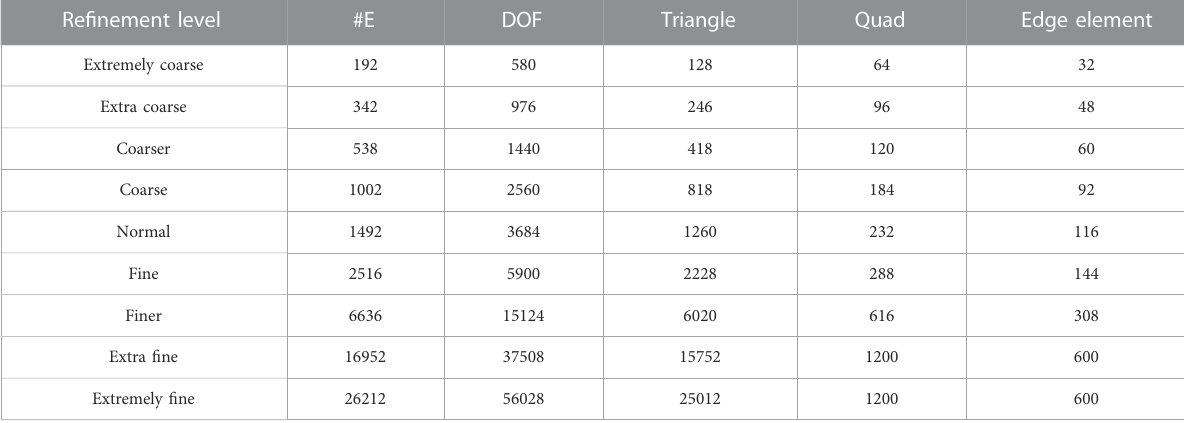
TABLE 1 Mesh statistics at different re fi nement